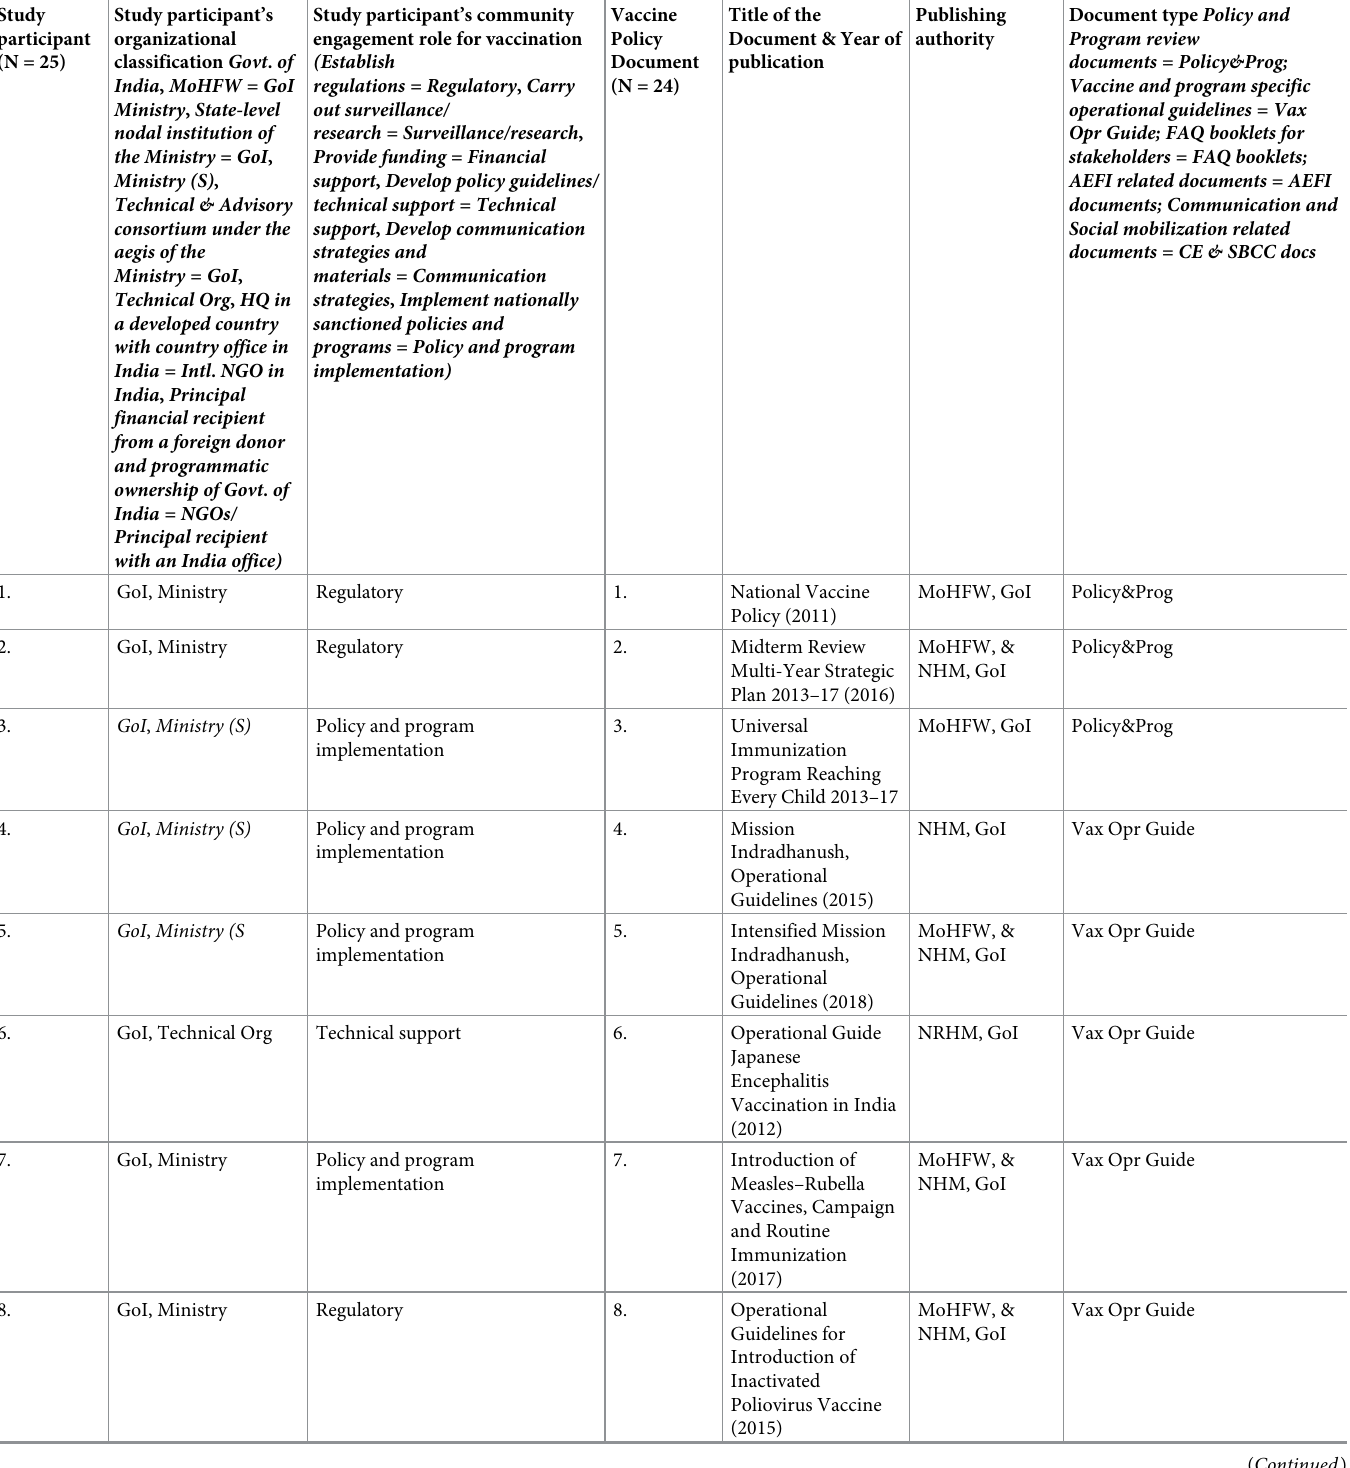
Table 1. Overview of vaccine decisionmakers and policy documents in India selected for this study, 2018. Study participant (N =